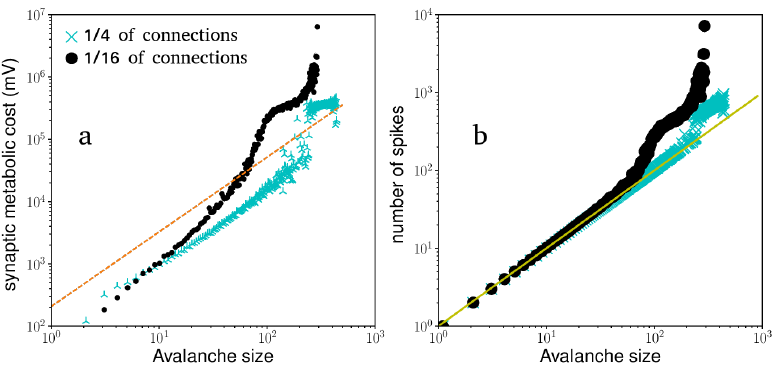
Figure 9. Metabolic cost of disconnected networks. ( a ) Synaptic cost. ( b ) Number of spikes. We set η = 0.5 and τ = 1.3 ms. Two cases of disconnection are shown: 1/4 of the total links with w = 10 mV, and 1/16 of the total links with w = 50